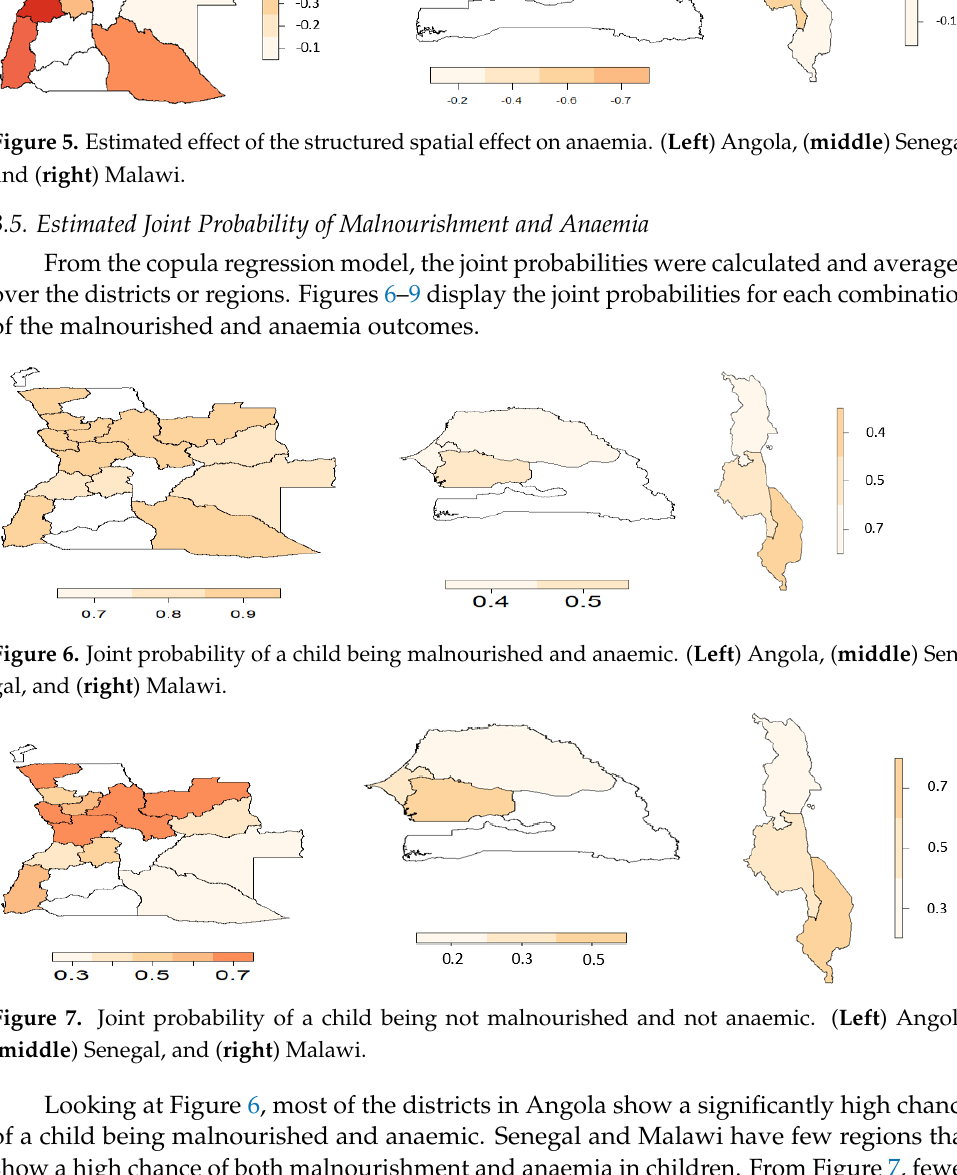
Figure 8. Joint probability of a child being not malnourished and anaemic. ( Left ) Angola, ( middle ) Senegal, and ( right ) Malawi.